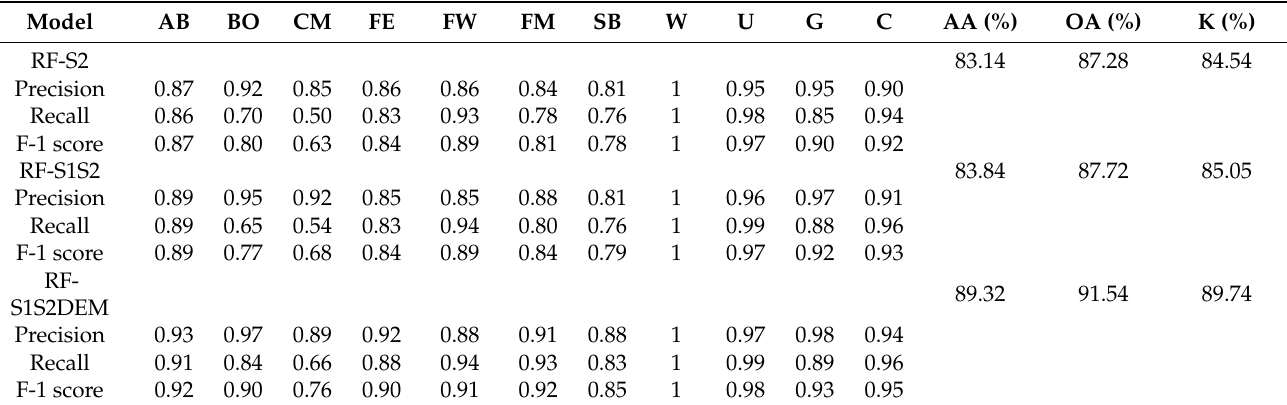
Table 5. Results of the RF classifier with different data sources in terms of average accuracy, preci- sion, F1-score, and recall (AB = aquatic bed, BO = bog, CM = coastal marsh, FE = fen, FM = fresh- water marsh, FW = forested wetland, SB = shrub wetland, W = water, U = urban, G = grass, C = crop, AA = average accuracy, OA = overall accuracy, K = kappa, S1 = Sentinel-1, S2 = Sentinel-2, DEM = DEM from LiDAR data).